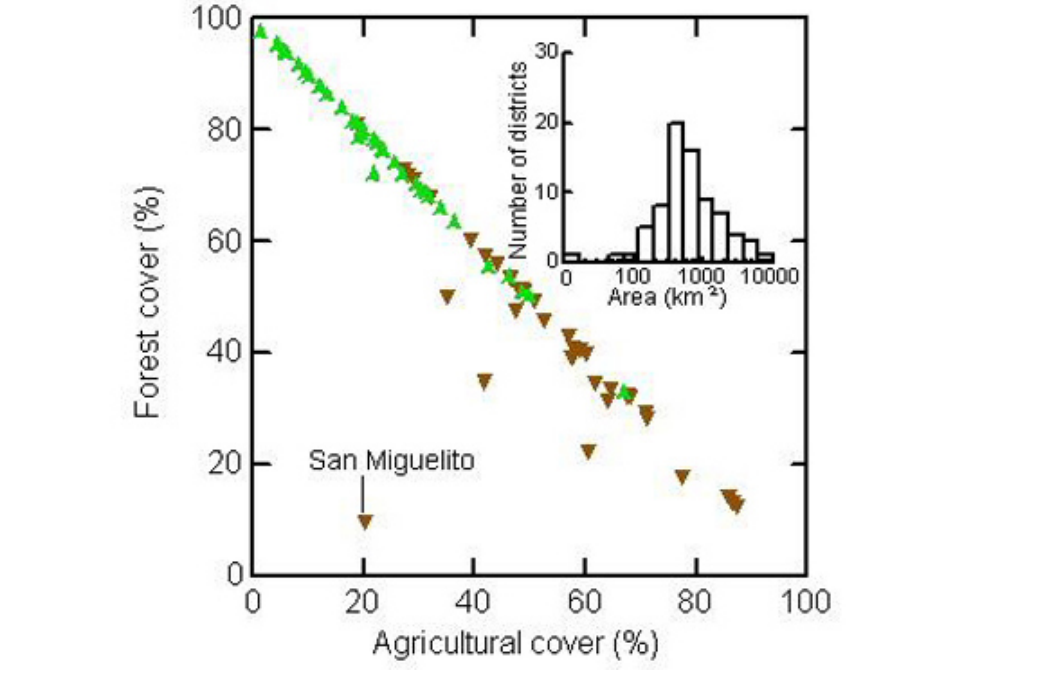
Fig. 3. The relationship between agricultural land cover and forest cover in 2000 for the 76 districts that compose Panama. Brown downward-pointing triangles indicate districts that were largely deforested before 1947; green upward-pointing triangles indicate districts that were largely forested in 1947. The inset is a histogram of the areas of districts. Districts that fall on the negatively sloping diagonal line are covered entirely by forest and agriculture. Agricultural land cover includes market-oriented crops and animals, subsistence agriculture, and tree plantations. Forest cover includes all natural vegetation that potentially has a closed tree canopy, including very young secondary forest or rastrojo (< 5 yr old), older secondary and mature terra firme forests, mangrove forests, and other flooded forests dominated largely by cativo ( Prioria copaifera ) or orey ( Campnosperma panamensis ). The district of San Miguelito is largely urban and was omitted from all analyses. Open water, tidal flats and low inundated vegetation were